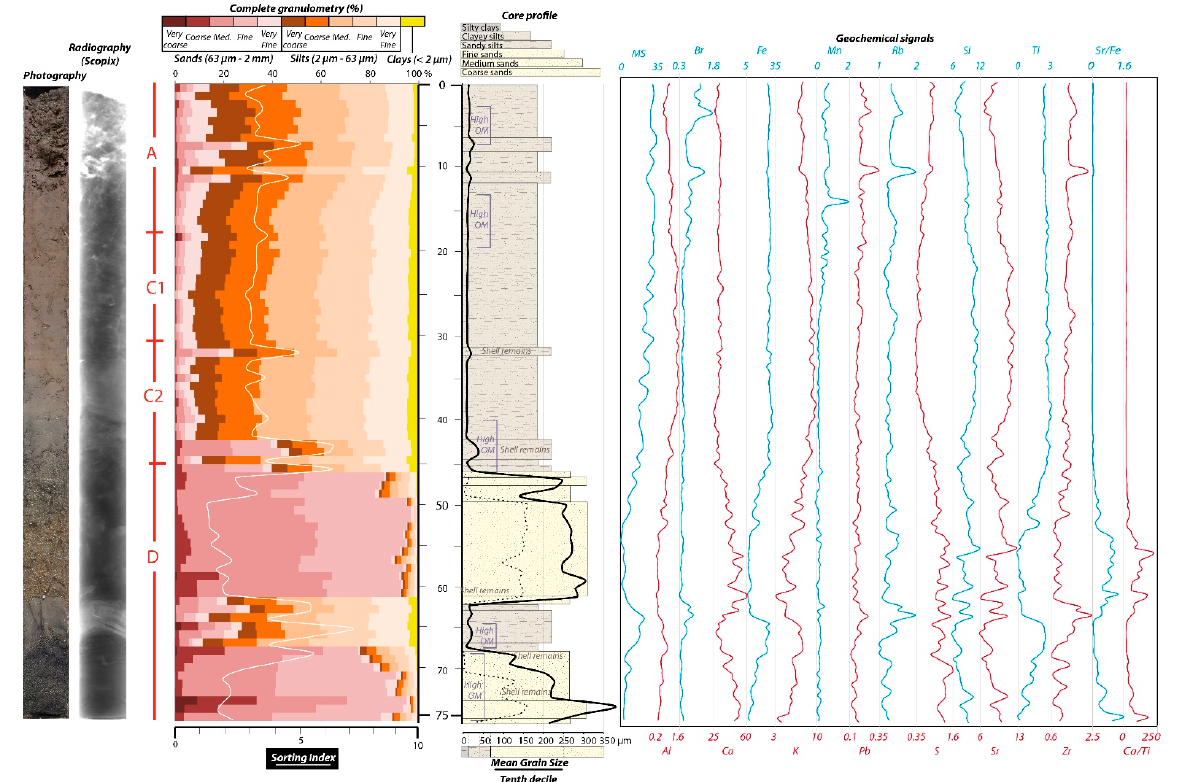
Figure 5. BH-D core log with photography, radiography, grain size results, and geochemical signals.